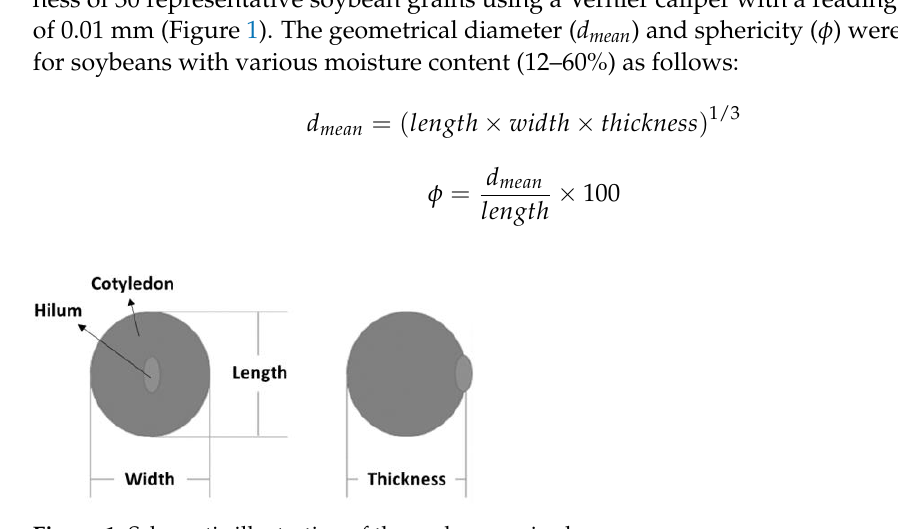
Figure 1. Schematic illustration of the soybean grain shape.